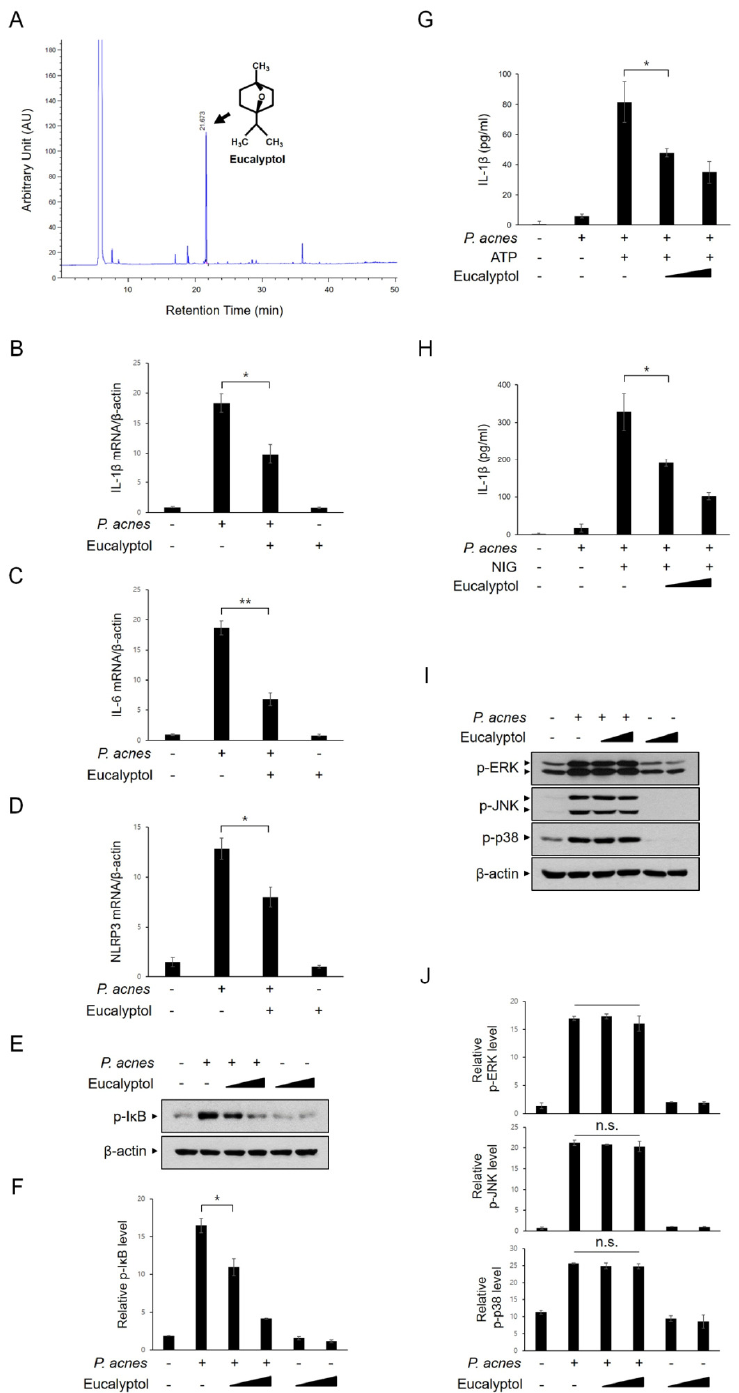
Figure 6. Eucalyptol inhibits P. acnes -induced inflammatory signaling pathways. ( A ) Isolation of